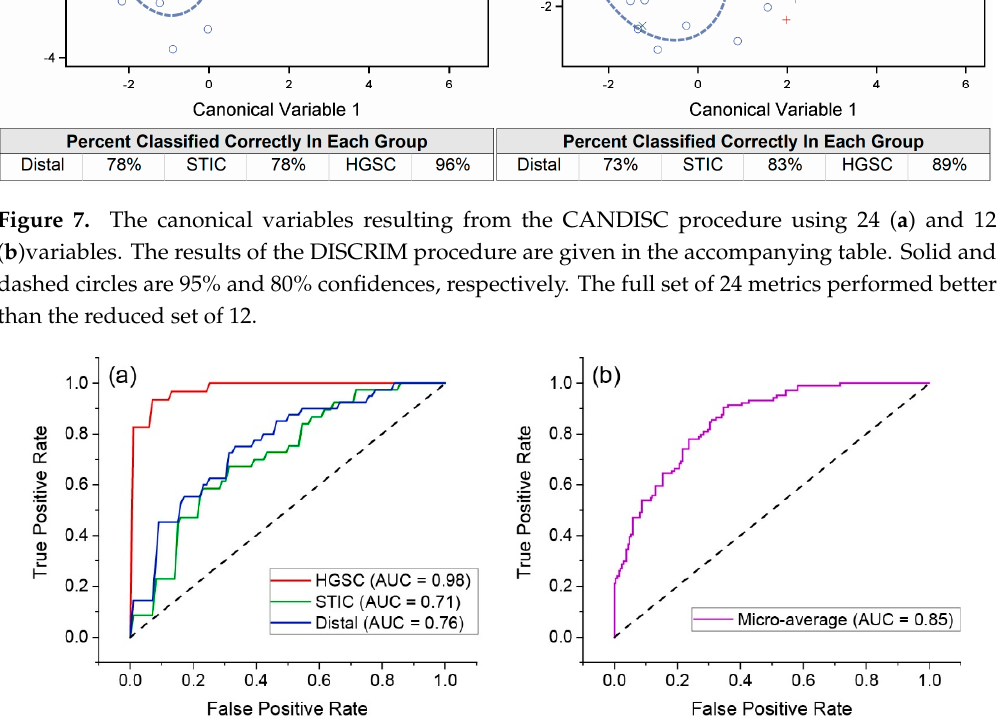
Figure 8. Receiver operator characteristic (ROC) curves for classification accuracy, where ( a ) and ( b ) are one vs. the rest and cohort accuracy, respectively.